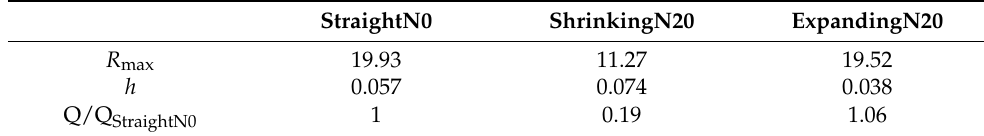
Table 3. Bubble energy when different nozzles were installed.